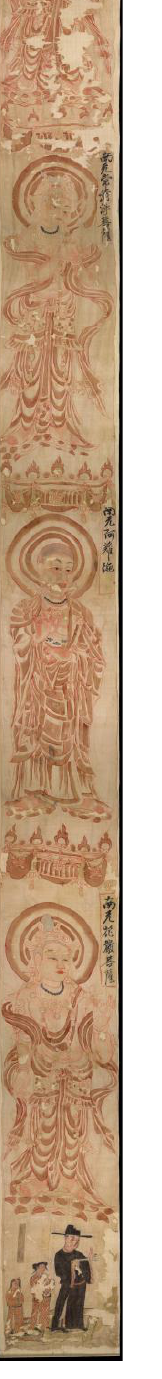
Figure 3. Long Banner with Bodhisattvas (Stein Painting 196), 956 CE (?), ink and colors on silk, H. 341.0 cm, W. 28.5 cm, 1919,0101,0.196, British Museum. © The Trustees of the British Museum.